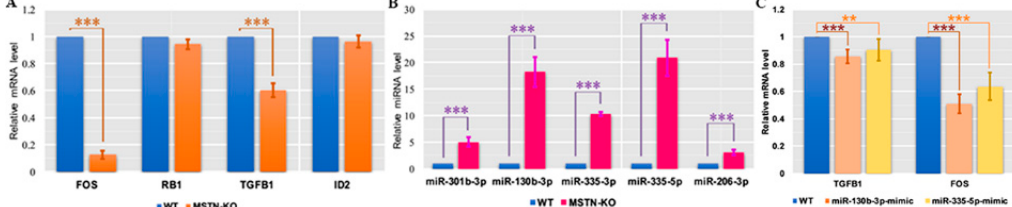
Figure 7. Expression of selected genes and miRNAs in the WT and MSTN-KO groups. ( A , B ) Expression levels of four DEGs and five DEMs in the WT and MSTN-KO groups measured by qRT-PCR and normalized to GAPDH and U6 snRNA expression levels, respectively. ( C ) Expression levels of TGFB1 and FOS in WT, miR-130b-3p mimics and miR-335-5p groups. The experiments were performed in triplicate with three biological replicates for each gene or miRNA. All data are shown as the mean ± SEM. Two-tailed Mann–Whitney U tests were used for pairwise comparisons between groups. ** p < 0.01, *** p < 0.001.